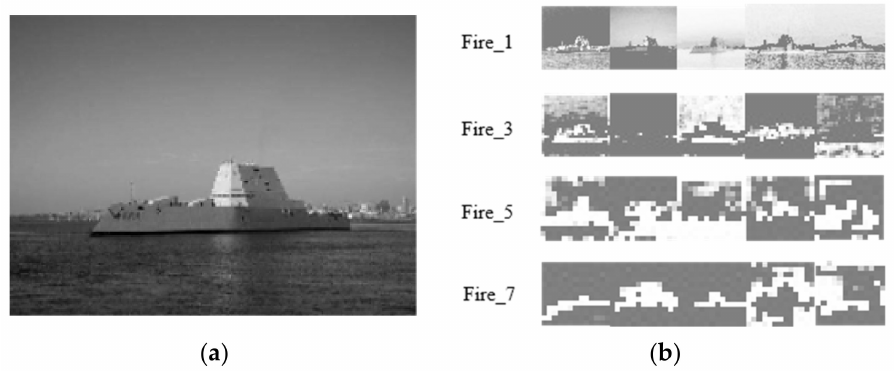
Figure 7. Feature maps of some neurons in the Fire module of SqueezeNet. ( a ) Input image of the network; ( b ) result of the characteristic graph of some channels of SqueezeNet’s Fire1, Fire3, Fire5, and